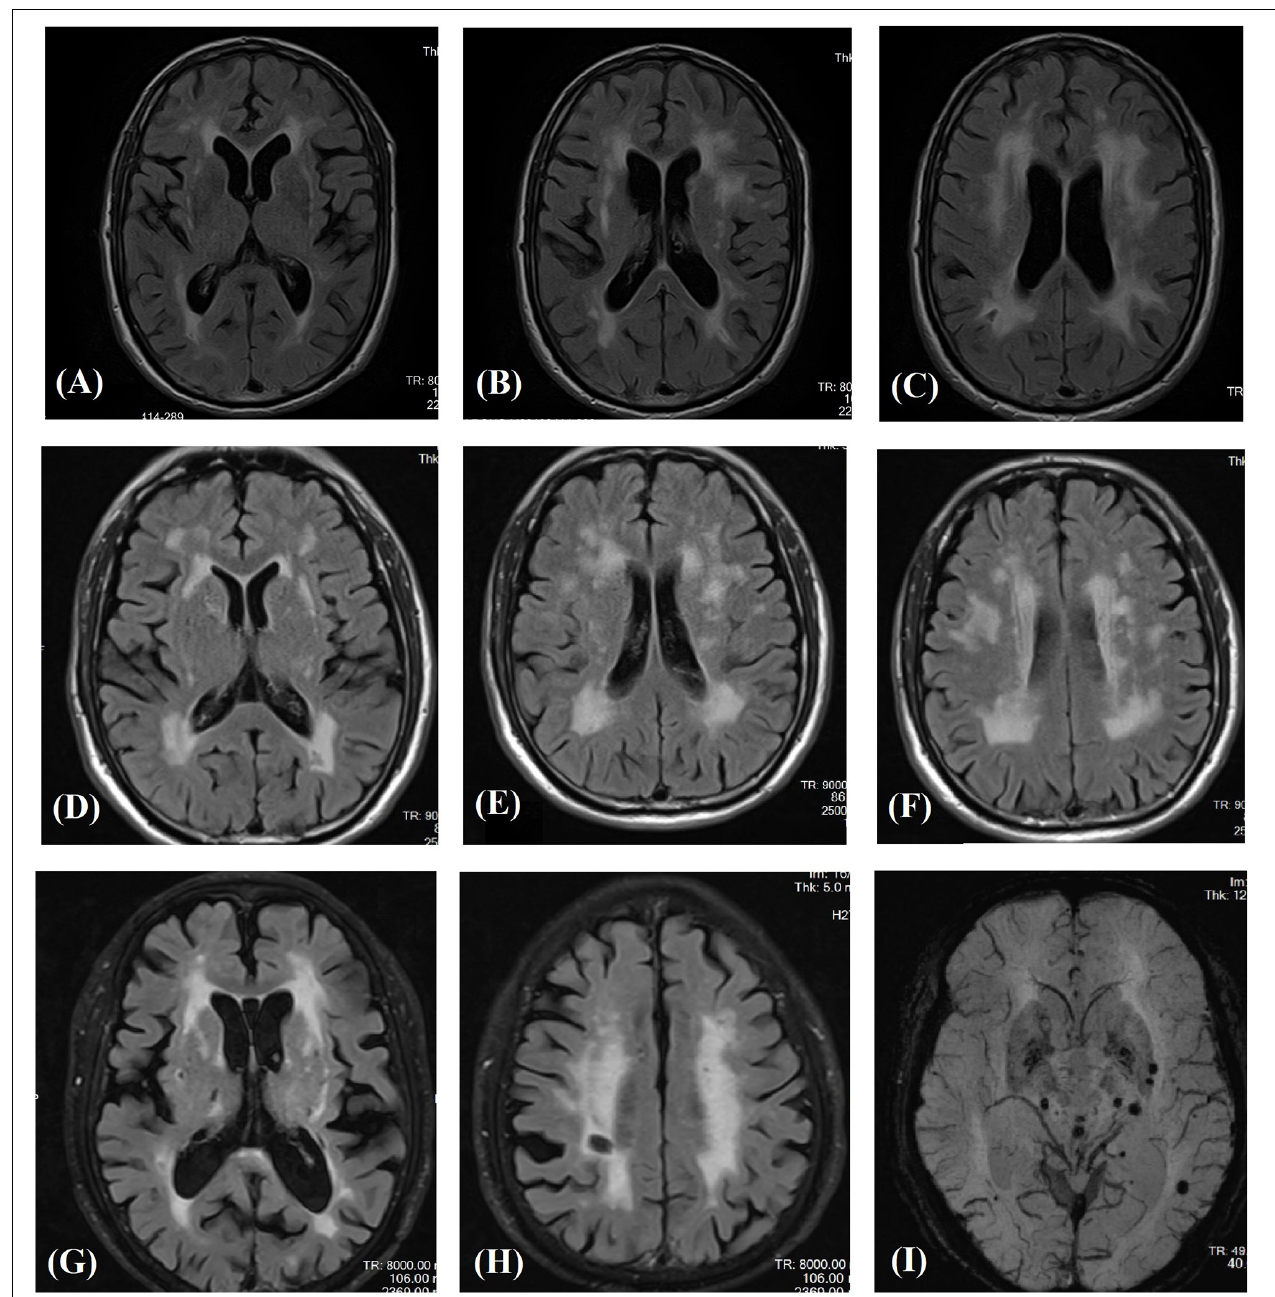
FIGURE 3 | Magnetic resonance images in three patients carrying novel NOTCH3 variants outside EGFr coding region. Fluid-attenuated inversion recovery images of the carrier of S2203Y (A–C) , V1922L (D–F) , and R1761H (G,H) showing multiple subcortical lacunar infarcts and characteristic diffuse leukoaraiosis with involvement of the external capsule. SWI images showed multiple microbleeds in basal ganglion and subcortical region of the carrier of R1761H (I)